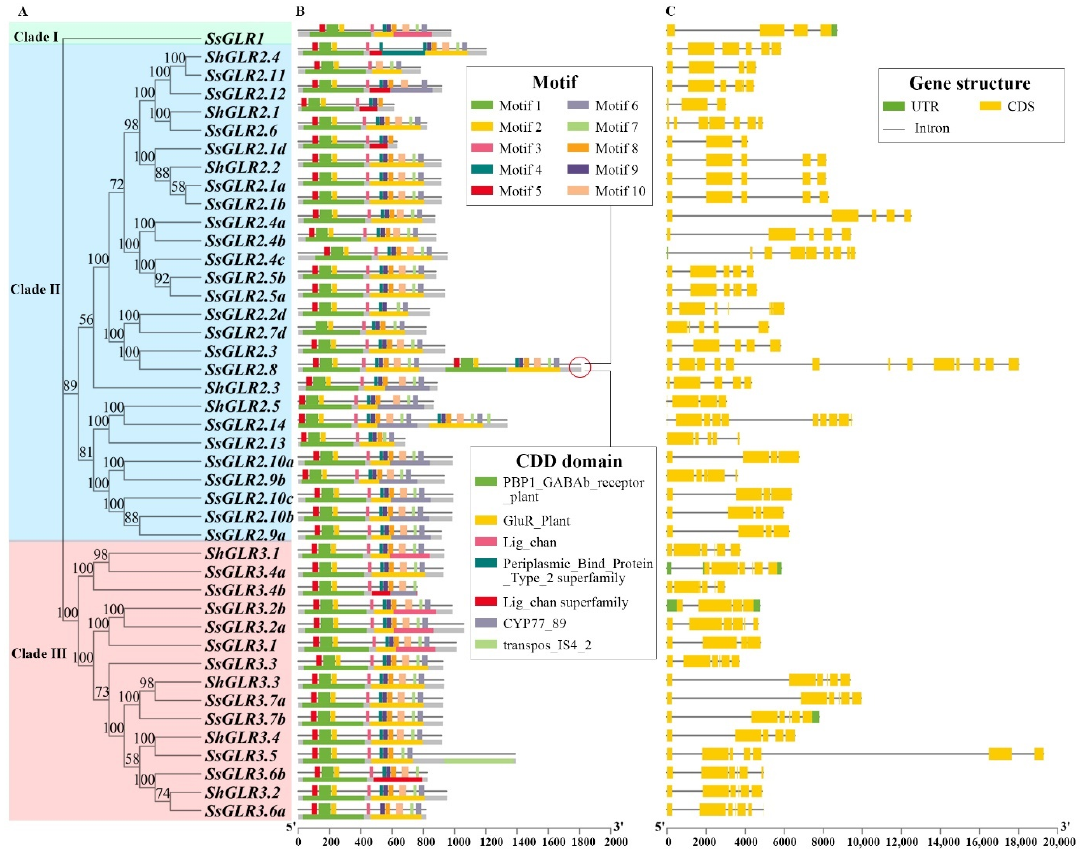
Figure 3. A schematic diagram of phylogenetic tree, conserved motif, and gene structure of SsGLRs and ShGLRs. ( A ) A phylogenetic tree of sugarcane GLRs. The clade name was labeled accordingly and the number on the branch of phylogenetic tree represented the bootstrap value. ( B ) The conservative motif structure of sugarcane GLRs. The 10 motifs were displayed in different colors and correspond one to one in the structural diagram, and the details of each motif were listed in the Table S9. The CDD domain located below motif was searched by Batch-CD. ( C ) The genetic structure of sugarcane GLRs . The green box represented the untranslated region (UTR), the yellow box represented the coding sequence (CDS), and the gray line represented the intron (Intron).